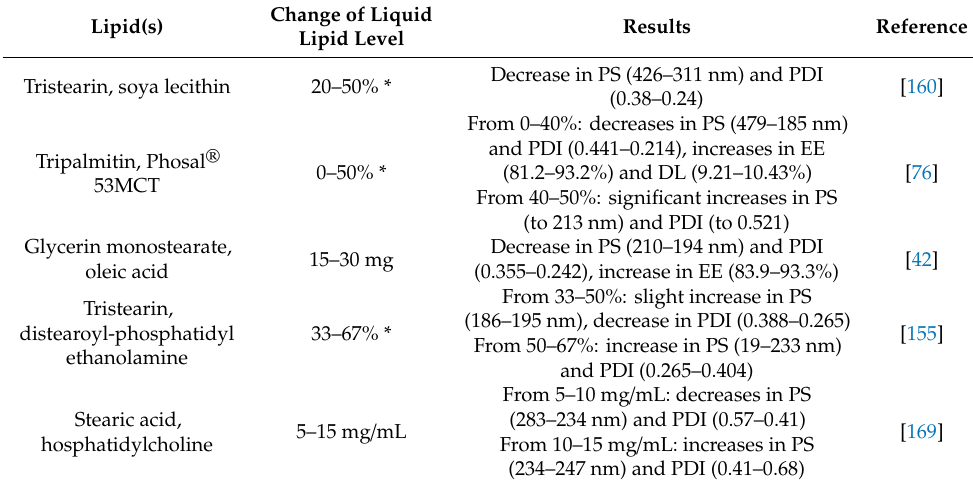
Table 4. E ff ects of liquid lipid level on the properties of